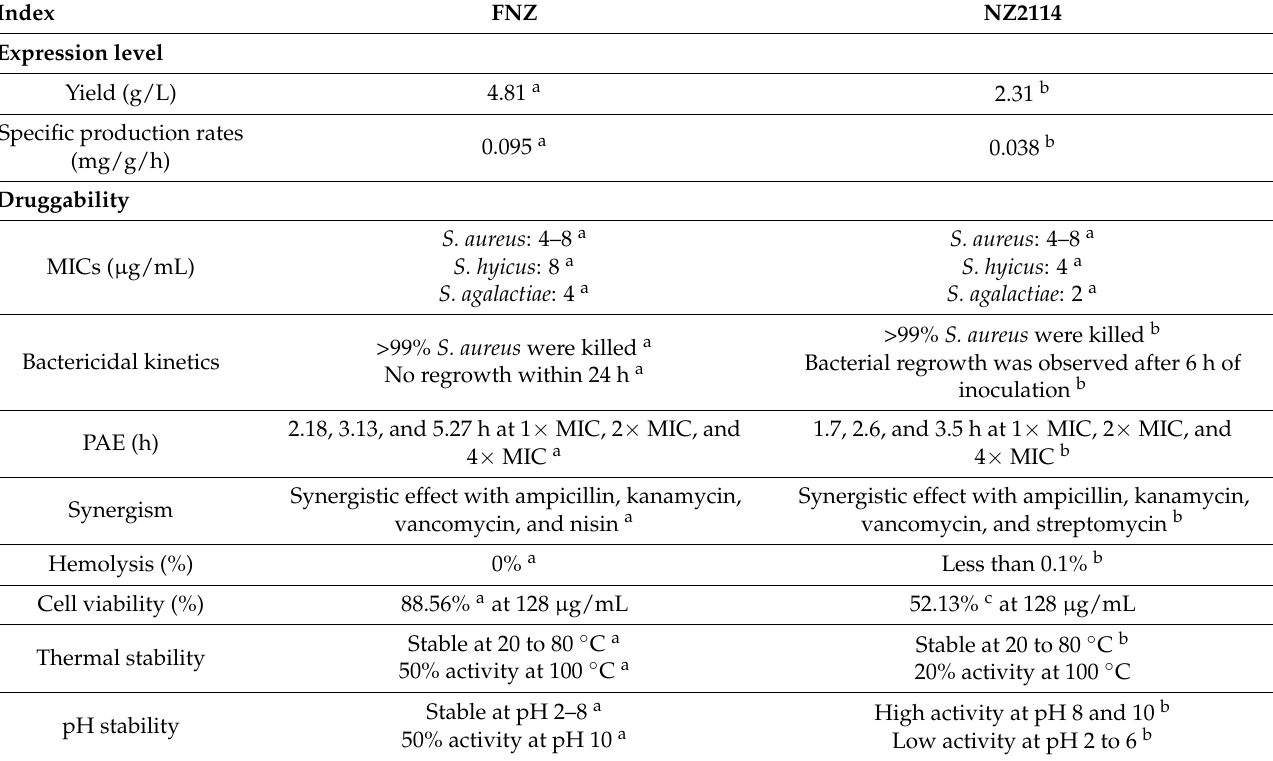
Table 4. Expression level and druggability of FNZ and